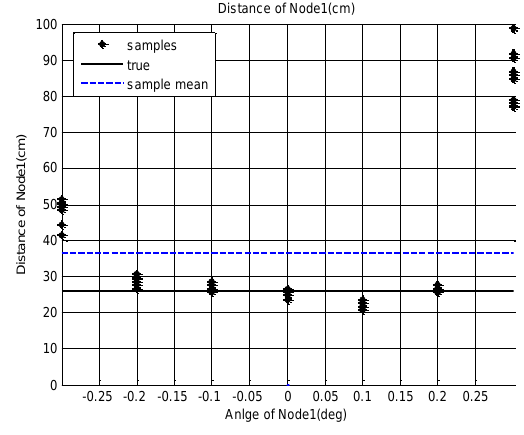
Figure 15. Scanning result of MEMS CCR with the 0.1 deg